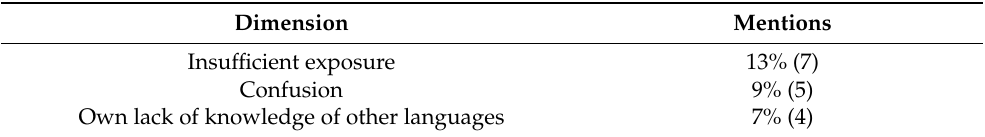
Table 9. Participants’ cognition about including other languages: main dimensions of the participants’ negative answers. Mentions are given as a percentage of the total number of participants, followed by the absolute number of mentions. More than one theme can be present in a single participant’s answer.